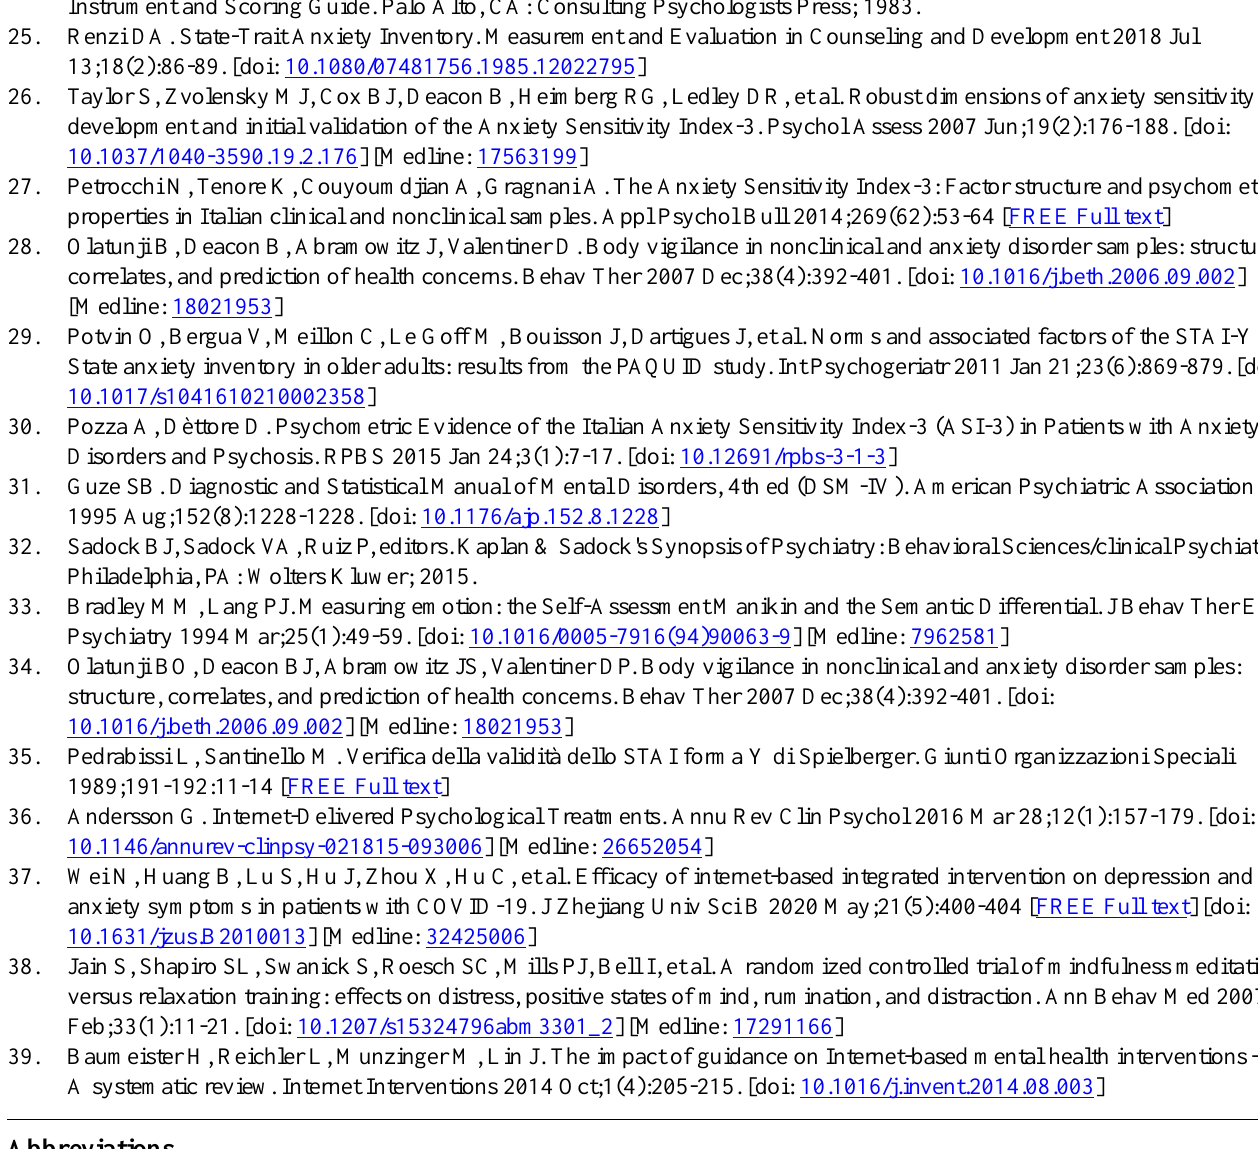
Abbreviations ANOVA: analysis of variance ASI-3: Anxiety Sensitivity Index-3 BVS: Body Vigilance Scale CONSORT: Consolidated Standards of Reporting Trials ES: effect size SAM: Self-Assessment Manikin STAI-Y: State-Trait Anxiety Inventory form-trait subscale VAS: Visual Analogue